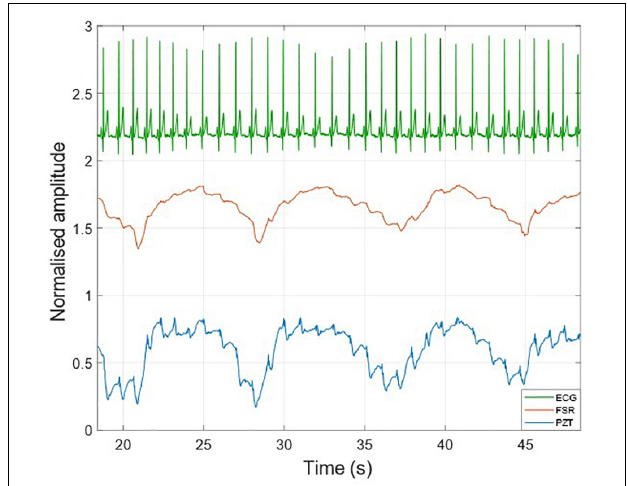
FIGURE 3 | Raw signals acquired from PZT (blue line) and FSR (red line) sensors with simultaneously acquired ECG (green line).